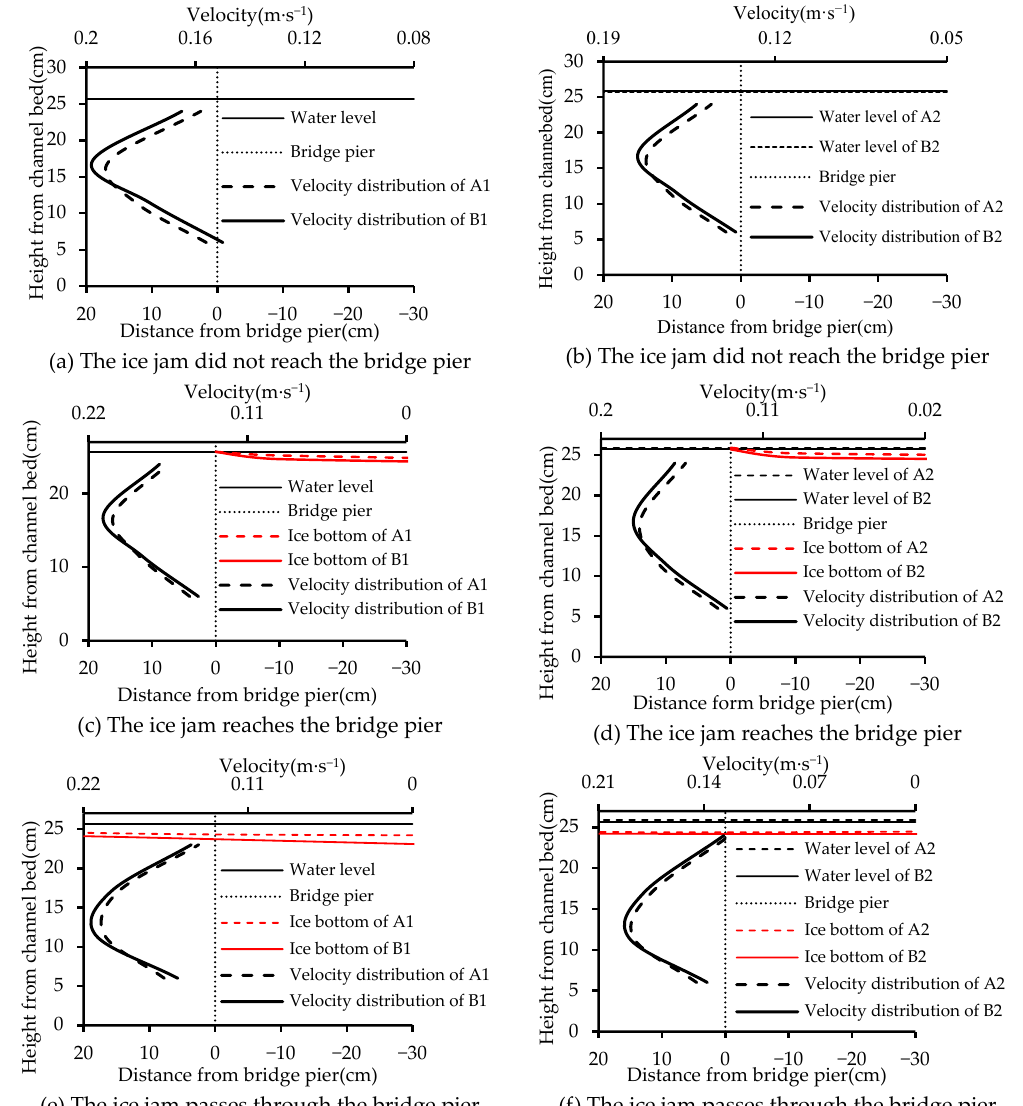
Figure 5. Velocity distributions with and without a pier scour for 3 cases: before the head of an initial ice jam reaching the pier ( a , b ); the head of an initial ice jam reaching the pier ( c , d ); after the head of an initial ice jam passing the pier ( e , f ).